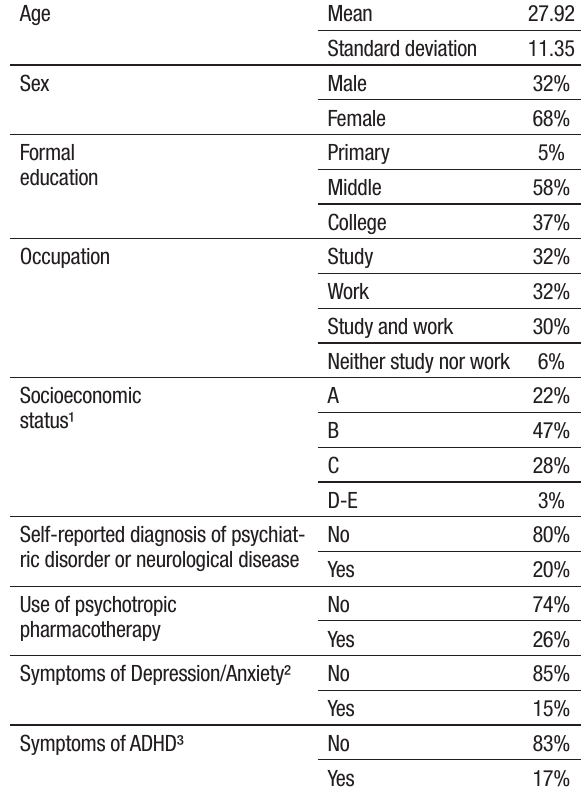
Table 1. Description of participants